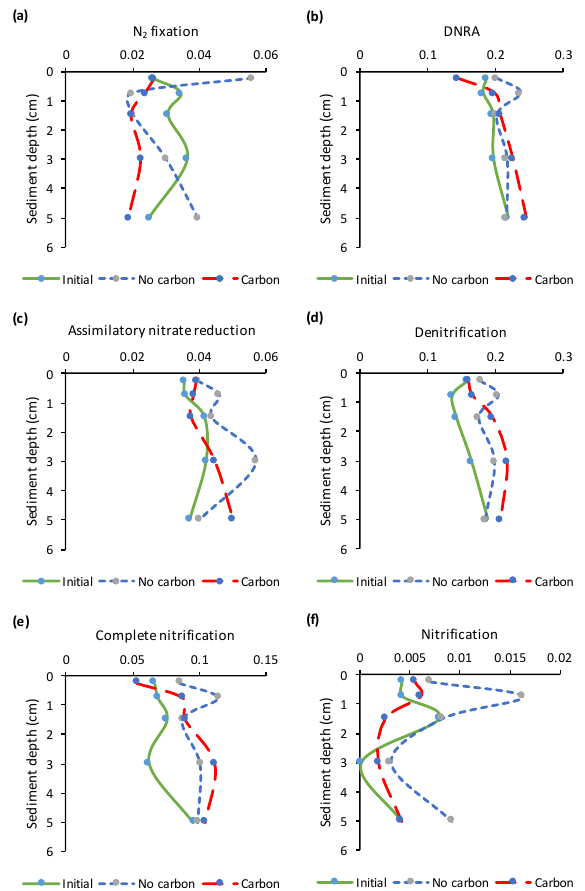
Figure 7. Vertical depth profiles of the predicted relative abun- dance of genes involved in the six nitrogen transformation path- ways: (a) nitrogen fixation, (b) dissimilatory nitrate reduction to ammonium (DNRA), (c) assimilatory nitrate reduction, (d) deni- trification, (e) complete nitrification and (f) nitrification, under the pathway module of nitrogen metabolism in the KEGG